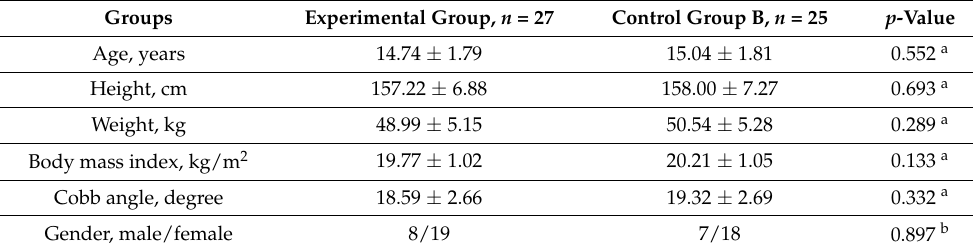
Table 1. Participants’ demographic